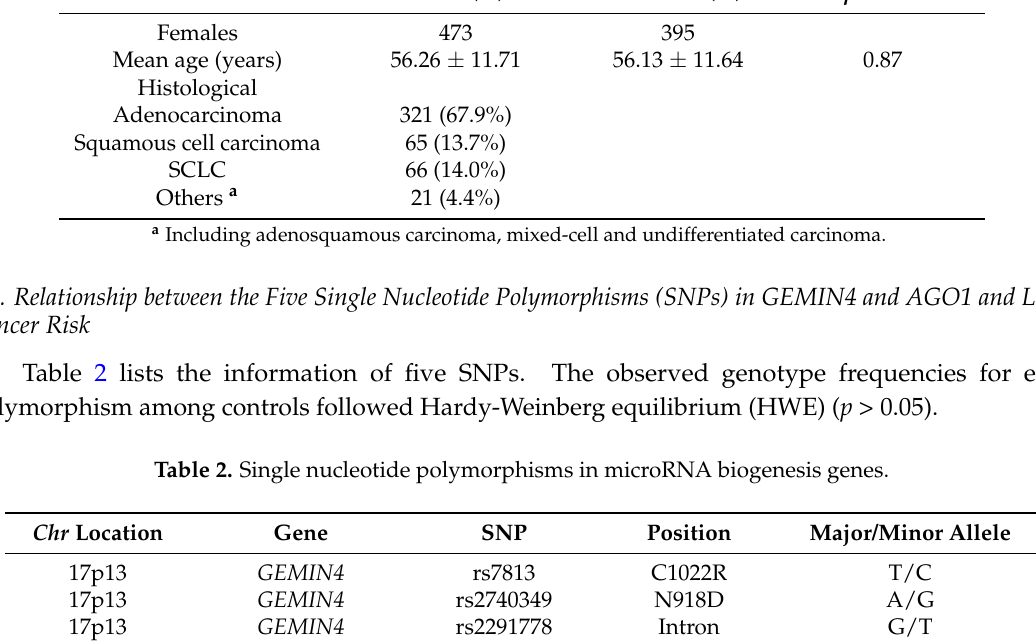
Table 1. Characteristics of lung cancer cases and cancer-free controls.